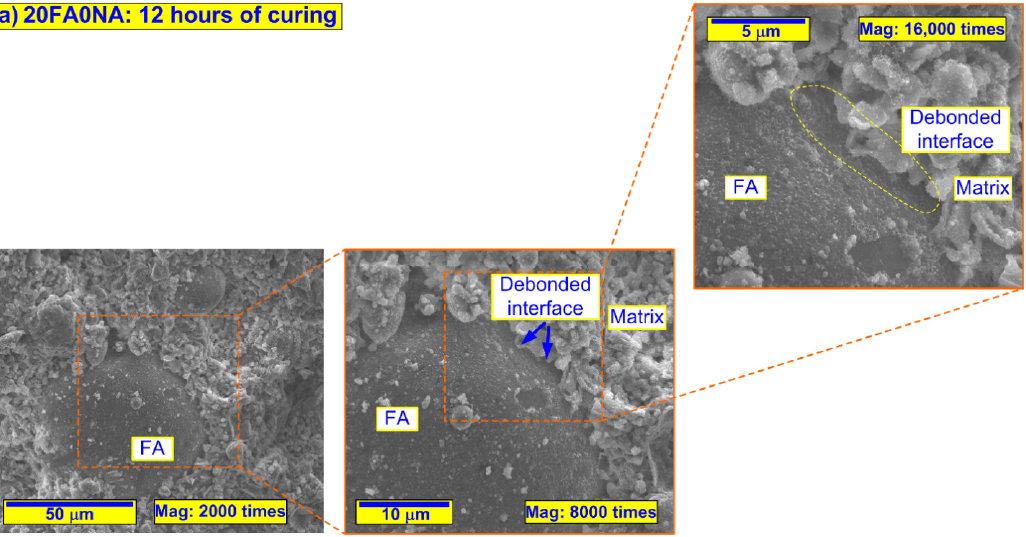
Figure 4. SEM micrographs of analyzed composites without FA at selected significant periods of curing: ( a ) 0FA0NA—12 h of curing, ( b ) 0FA4NA—12 h of curing, ( c ) 0FA0NA—24 h of curing, ( d ) 0FA4NA—24 h of curing, ( e ) 0FA0NA—72 h of curing, ( f ) 0FA4NA—72 h of curing.